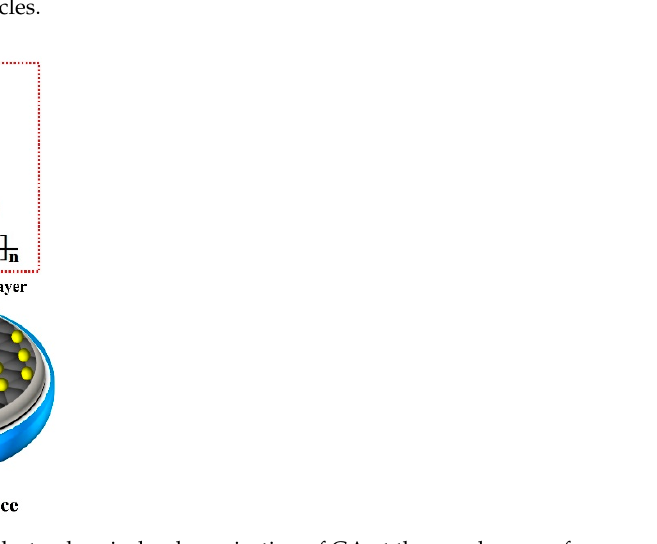
Scheme 1. Possible electrochemical polymerisation of GA at the graphene